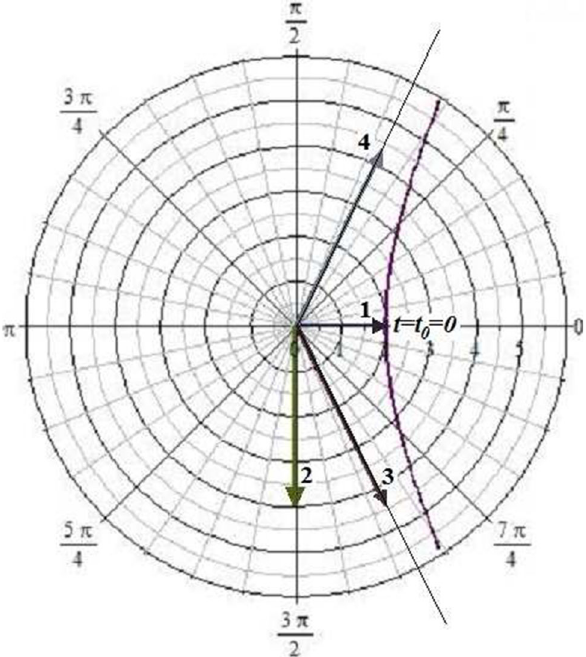
Fig. 2 de Sittertimelikegeodesic with φ 0 = 0 and t 0 = 0. The marked vectors are: ( 1 ) K